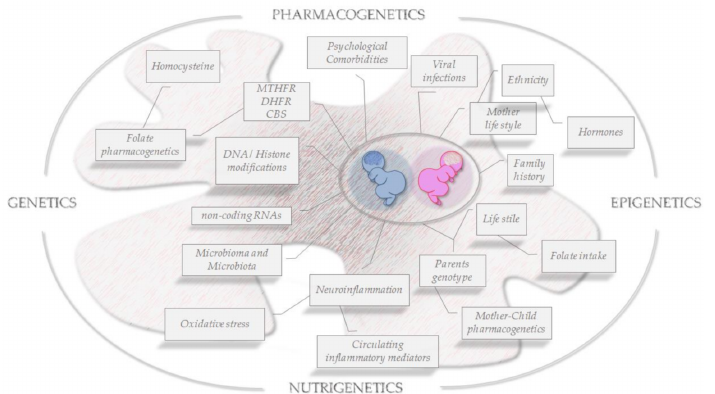
Figure 3. Folate OMICS-environment interactions on brain epigenomics. Snapshot of key risk factors for ASD development and key transgenerational pathophysiological features to be faced in a sex/gender